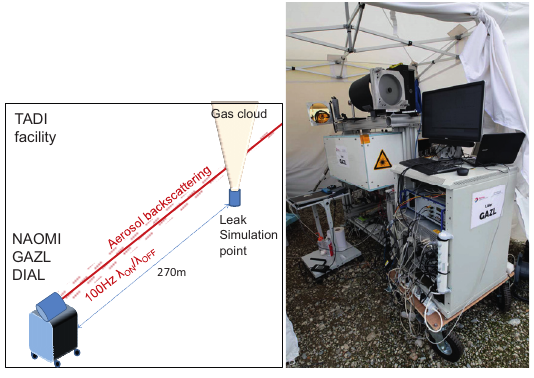
Fig. 3. NAOMI GAZL deployment scheme on TADI and picture of the